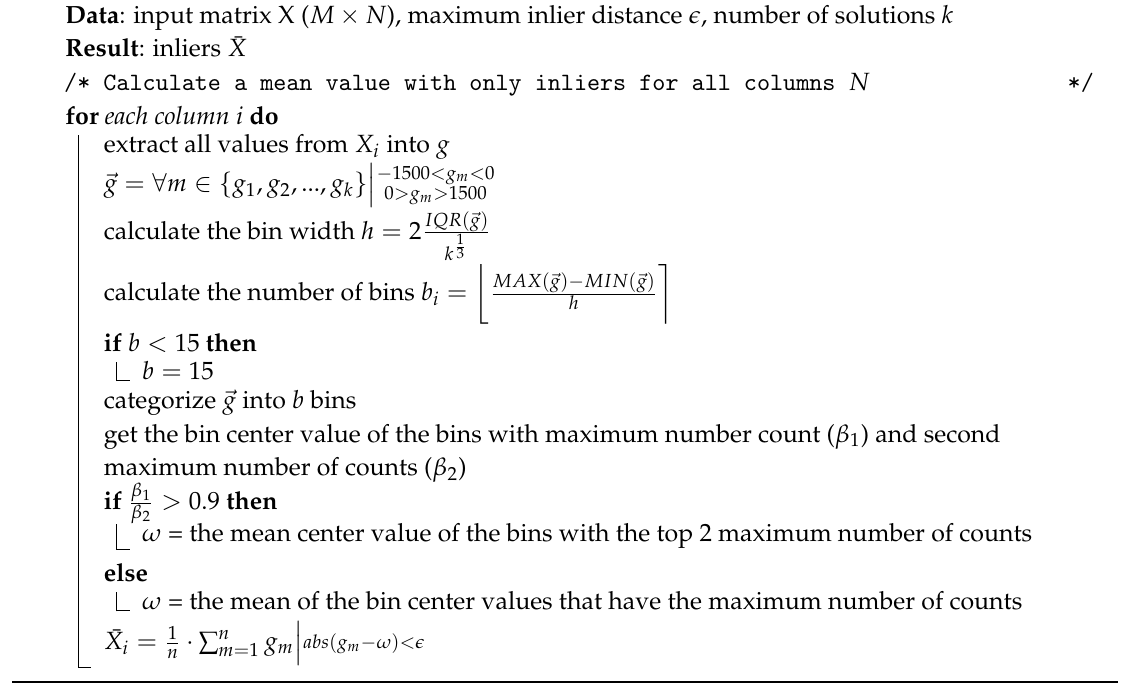
Algorithm 2: HBOS